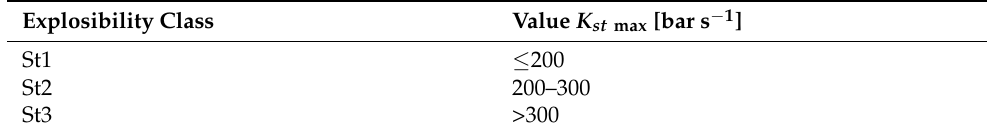
Table 1. Classes of dust explosibility [26].